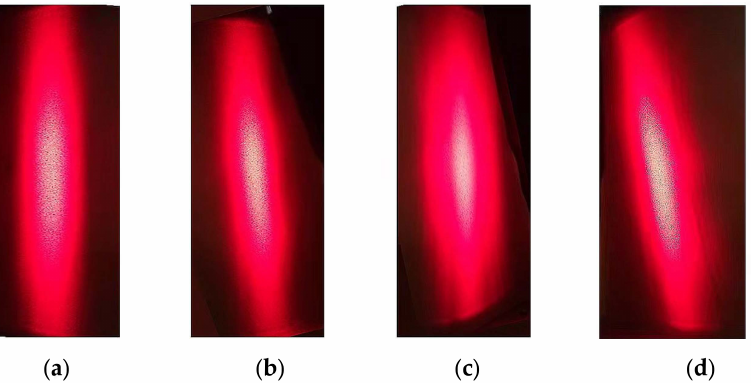
Figure 9. Diagram of the laser beam image ( a ) the laser beam image of bilateral trench structure ( b ) the laser beam image of right trench structure ( c ) the laser beam image of left trench structure; ( d ) the laser beam image of EEL structure.